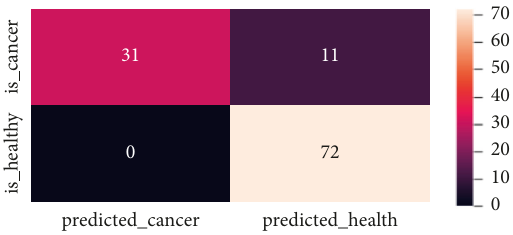
Figure 6: Confusion Matrices (without cross validation). Figure 7: Confusion matrices (with cross validation by using the random forest